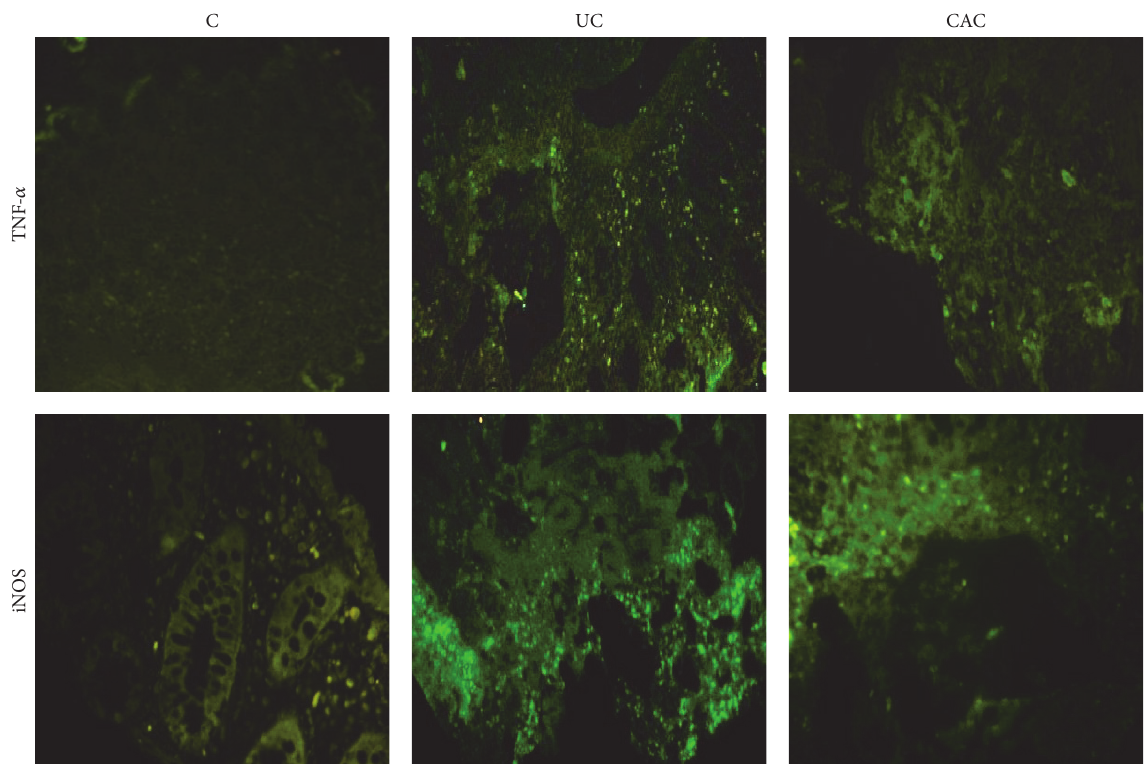
Figure 3: TNF- 𝛼 and NOS2 expression in inflamed colonic mucosa of active UC and CAC patients detected by immunofluorescent staining (IF). TNF- 𝛼 and NOS2 expression was upregulated in inflamed colonic mucosa (higher inflammation score) of active UC and CAC patients compared with control. Immunofluorescence staining of NOS2 (score 3) and TNF- 𝛼 (score 3) was more intense in inflamed colonic mucosa of UC patients compared with control (score 0). High score and intensity of NOS2 (score 3) and TNF- 𝛼 (score 3) were also evaluated in colonic mucosa of CAC patients (UC, ulcerative colitis, 𝑛 = 5 ; CAC, colitis associated cancer, 𝑛 = 3 ; C, control, 𝑛 = 4 ).